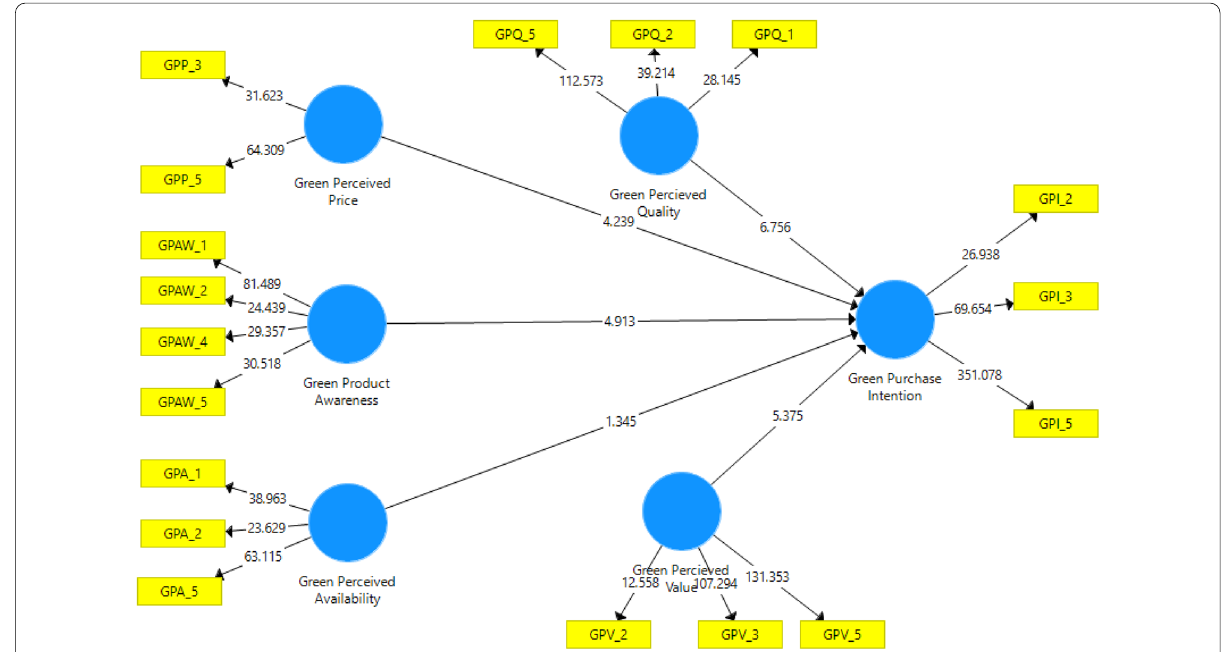
Fig. 2 Bootstrapping (inner model and